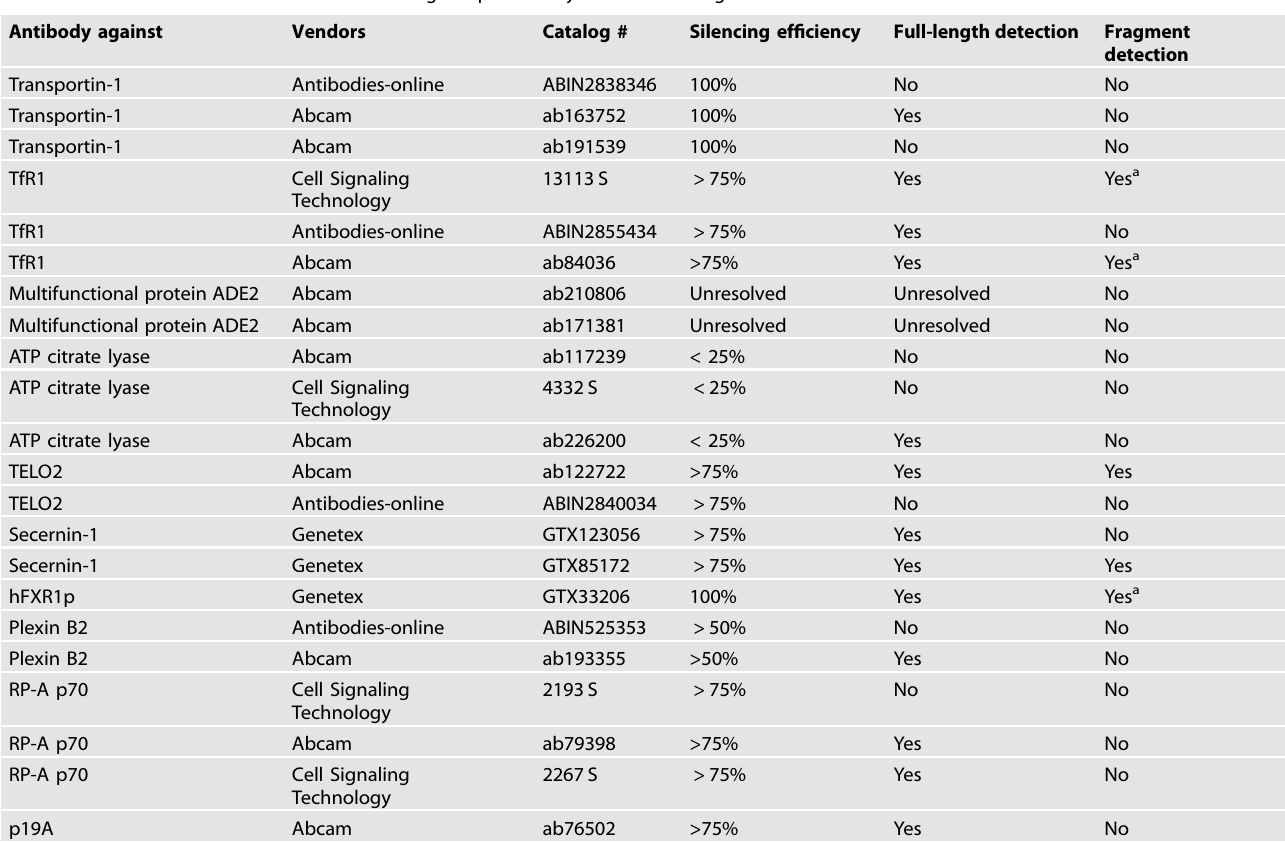
Table 2. Antibodies used to validate the cleavage of proteins by western blotting.